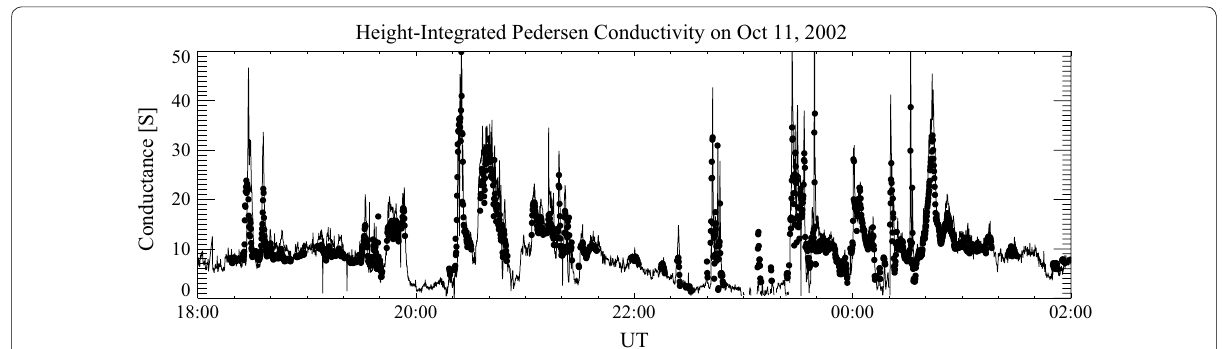
Fig. 16 Temporal variations of the corrected height-integrated Pedersen conductivities for October 11, 2002; the same as Fig. 12 except for the period between 18:00 UT on October 11 and 02:00 UT on October 12,